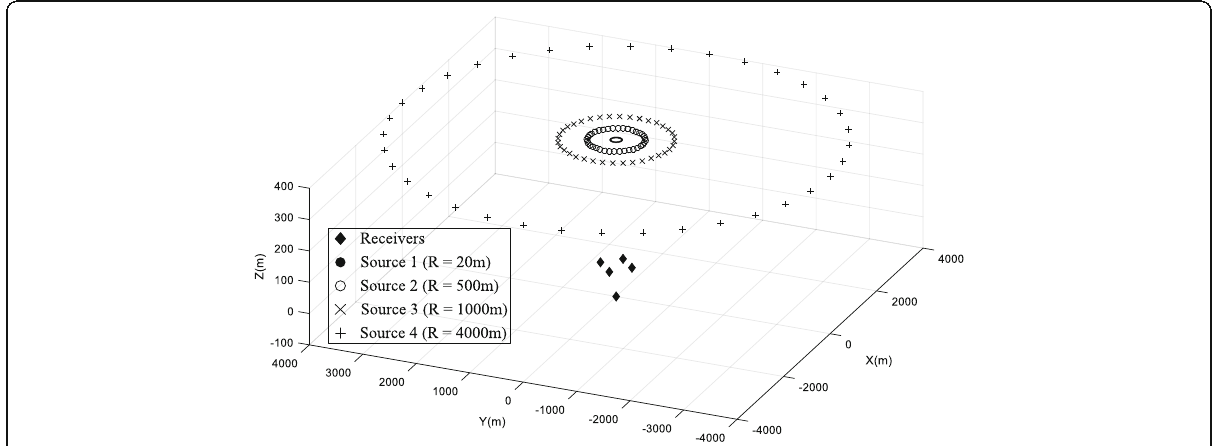
Fig. 3 Localization geometry of receivers and sources (circular